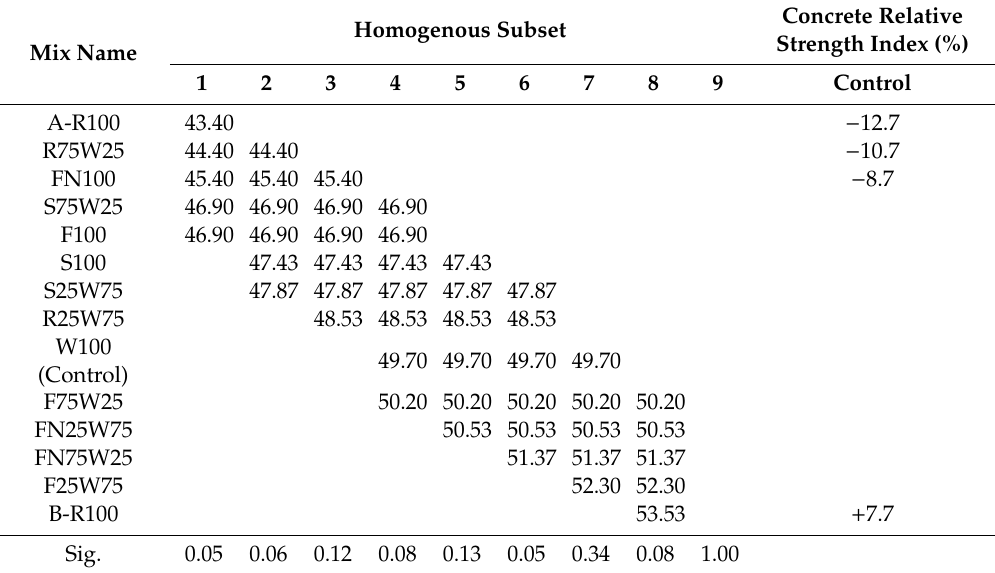
Table 9. Statistical significance of concrete compressive strength at 90 days was evaluated by general liner model multivariate—Tukey homogeneous